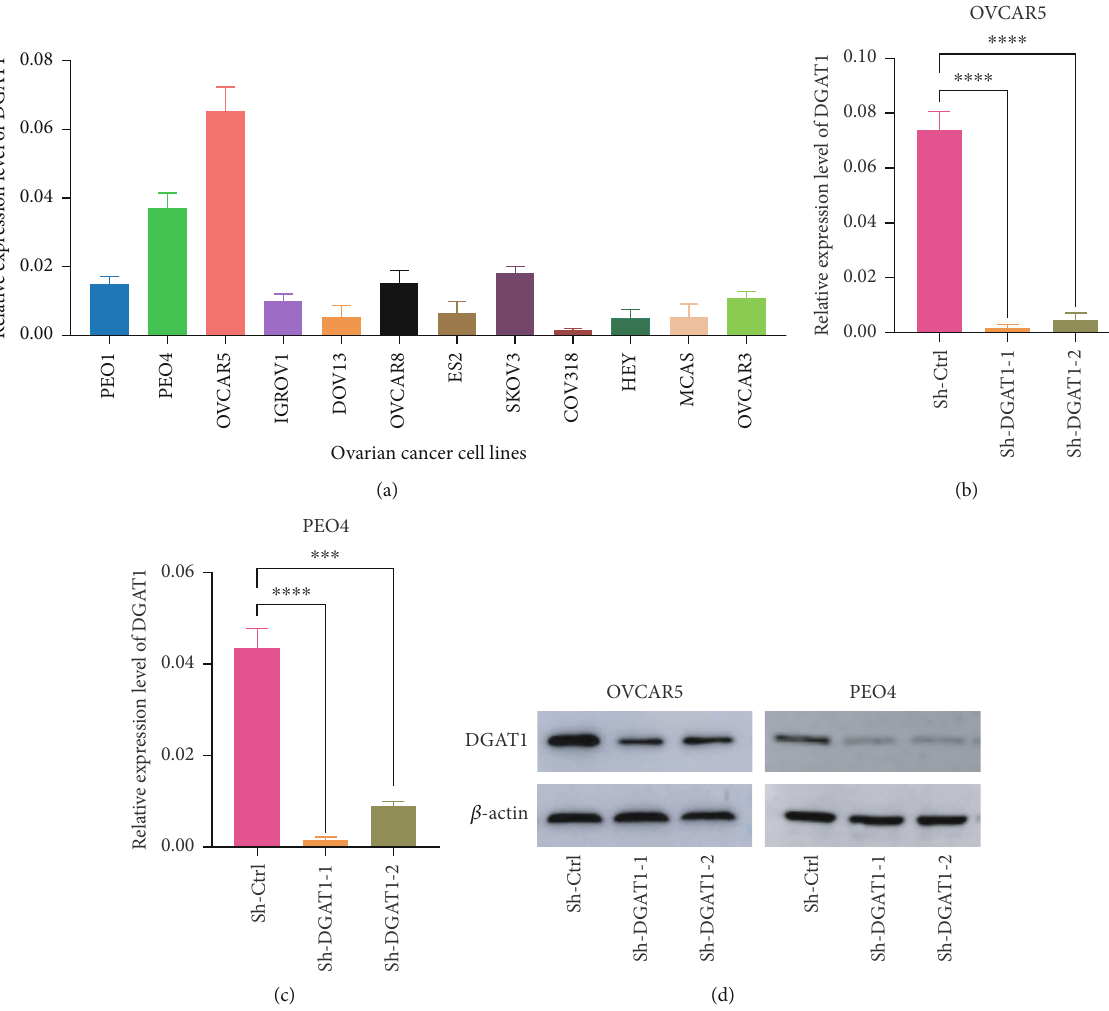
Figure 2: DGAT1 is overexpressed in OVCAR-5 and PEO4 cells. (a) DGAT1 mRNA expression in ovarian cancer cell lines. (b and c) qRT- PCR analysis of knockdown e ffi ciency of DGAT1 in OVCAR-5 and PEO4 cells. (d) Western blot tests the knockdown e ffi ciency of DGAT1 in OVCAR-5 and PEO4 cells ( p ≤ : 001 = ∗∗∗ , p ≤ : 0001 = ∗∗∗∗